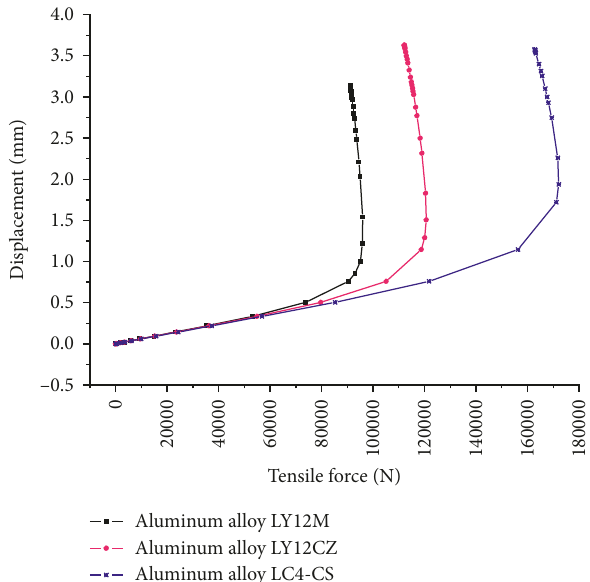
Figure 21: Tension and displacement diagram of the joint under different material